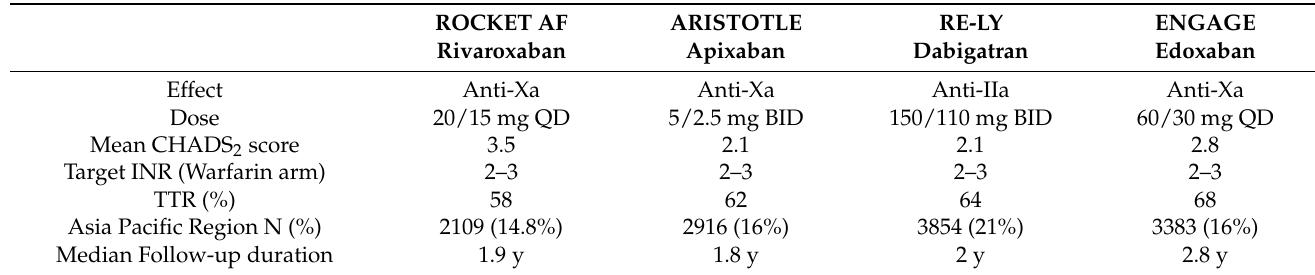
Table 2. Main characteristics of the four DOACs pivotal trials.